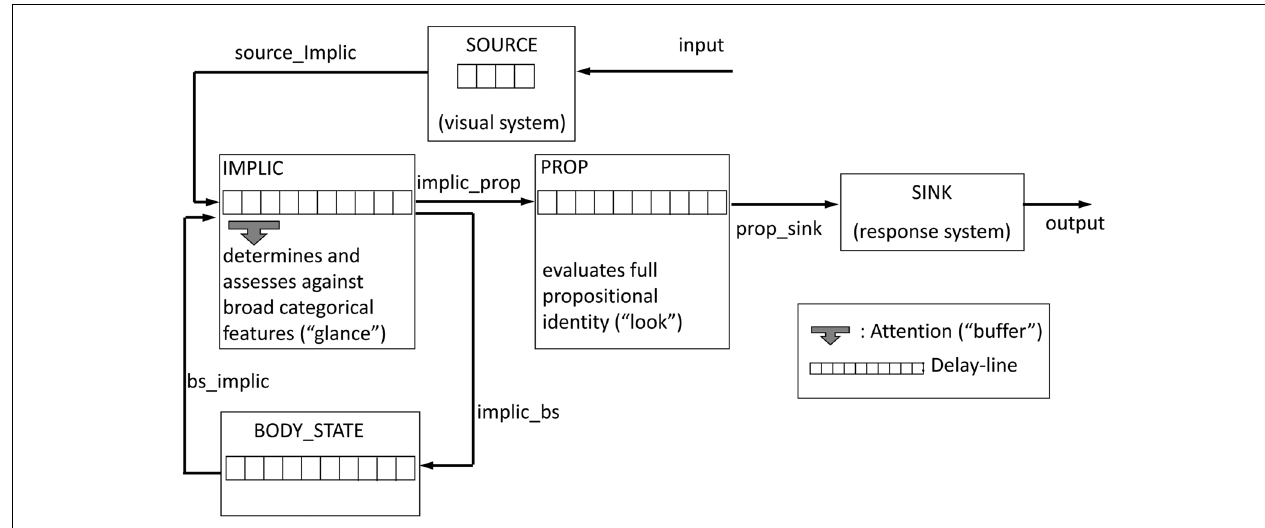
FIGURE 6 |The glance–look model extended with body-state